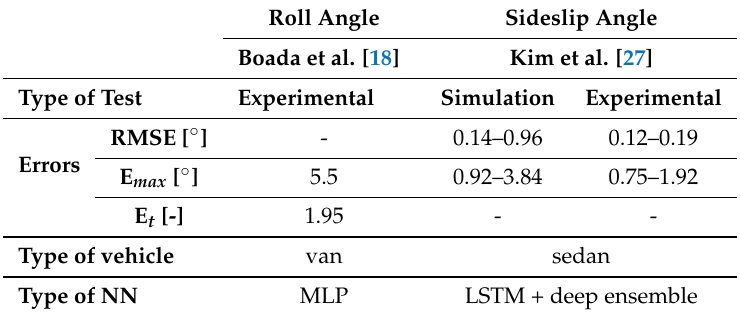
Table 4. Comparison with other methods for roll and sideslip angles